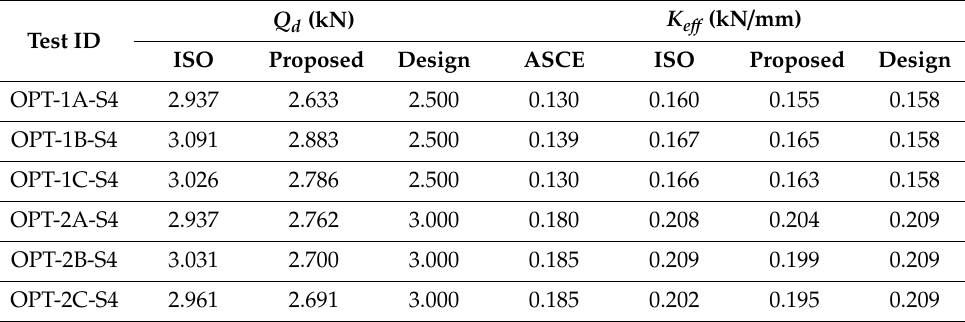
Table 7. Results of characteristic strength and e ff ective sti ff ness (D = ± 35mm).